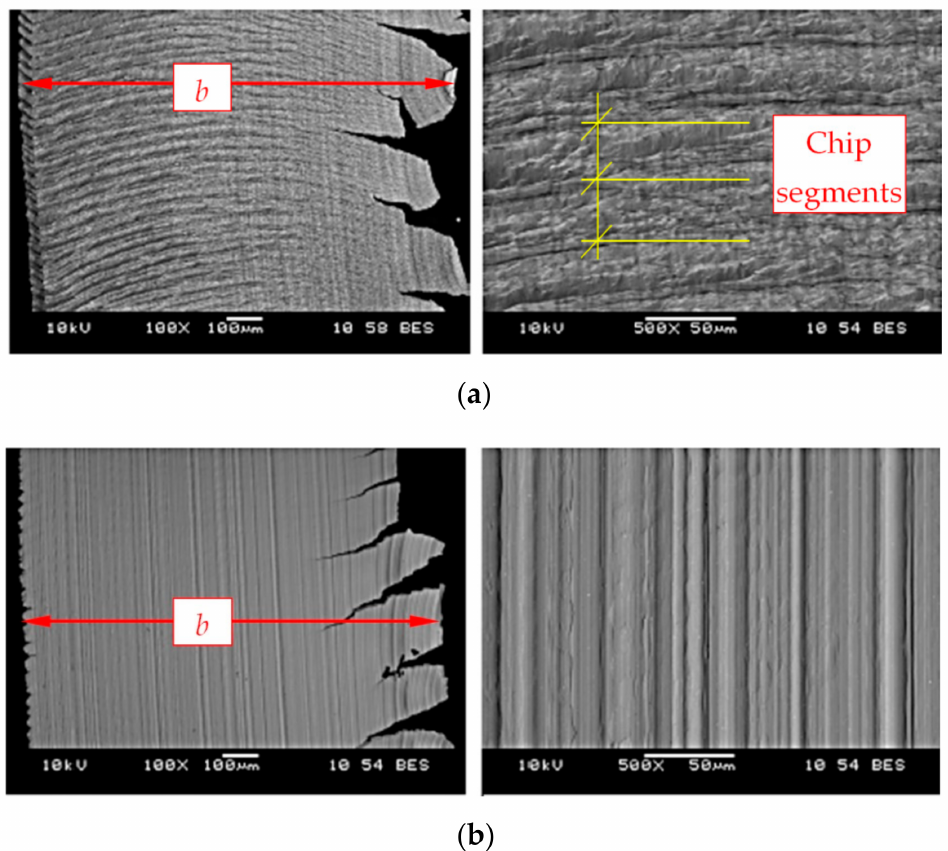
Figure 22. Microscopic images of the surface inside ( a ) and outside ( b ) of the chips; v c = 160 m/min, a p = 0.5 mm, b —chip